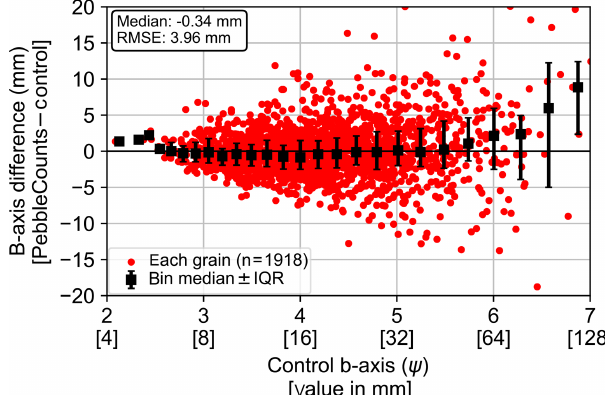
Figure 9. Measurement error of PebbleCounts (here the KMS re- sults) versus control on a grain-by-grain basis for overlapping grains in the coarser (1.16mmpixel − 1 ) imagery. There is an overall me- dian shift, but the binned medians do not display a consistent pat-